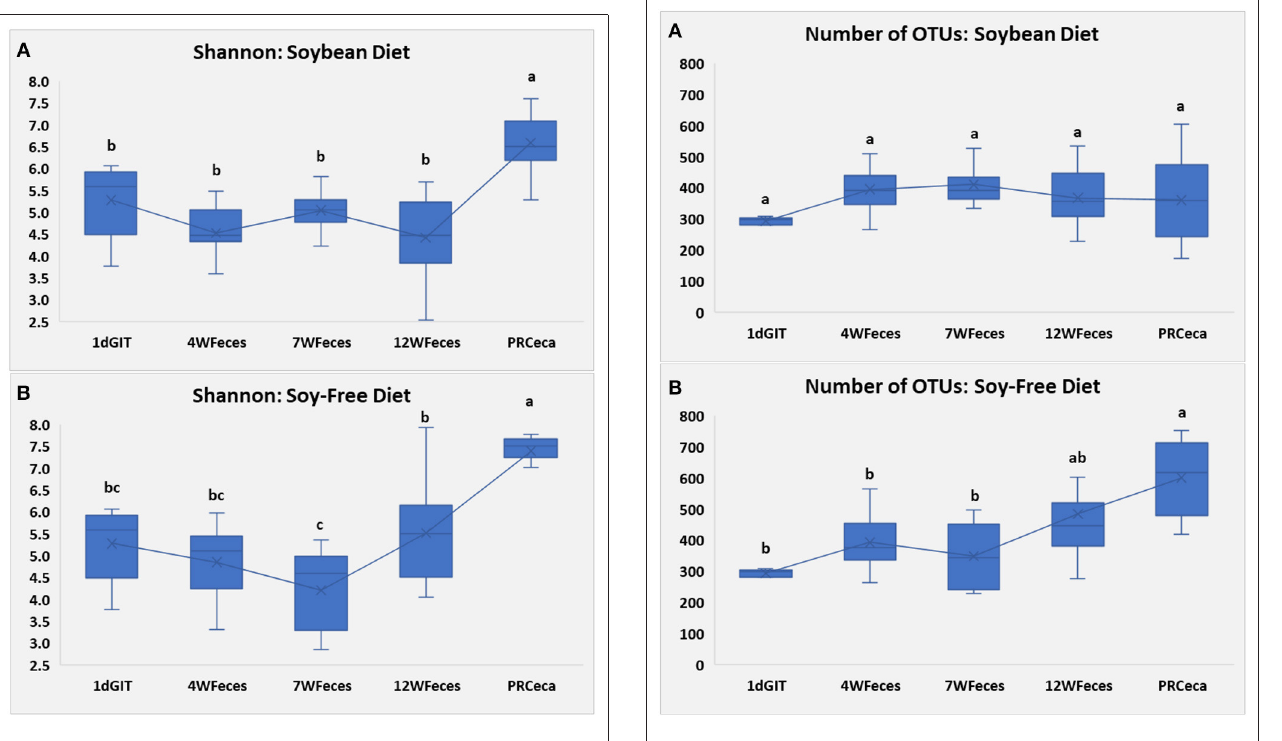
FIGURE 1 | Shannon Index for pasture-raised chicken over different stages of their lives: 1dGIT, Gastrointestinal contents from 1-day-old broilers; 4WFeces, Feces from 4-week-old broilers; 7WFeces, Feces from 7-week-old broilers; 12WFeces, Feces from 12-week-old broilers; PRCeca, Cecal contents collected during slaughter. (A) Broilers fed a soy-containing diet; (B) Broilers fed a soy-free diet. The lack of a common superscript letter (within the same diet) indicates significant differences ( P ≤ 0.05).